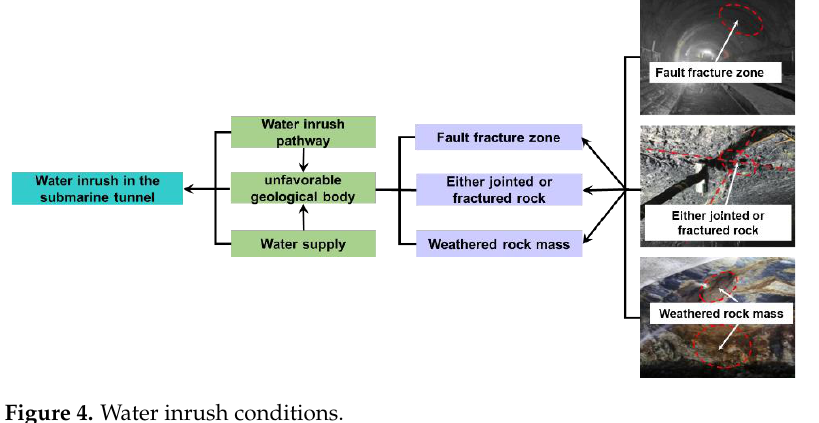
Figure 4. Water inrush conditions.